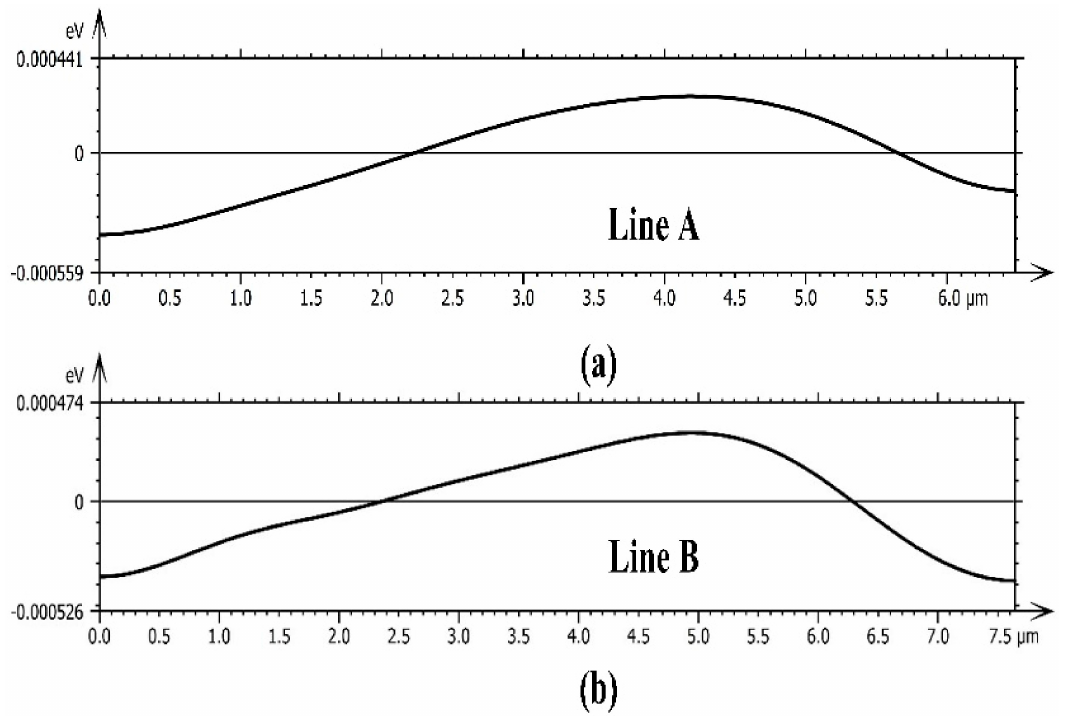
Figure 5. Emission energy change profiles of line A ( a ) and B ( b